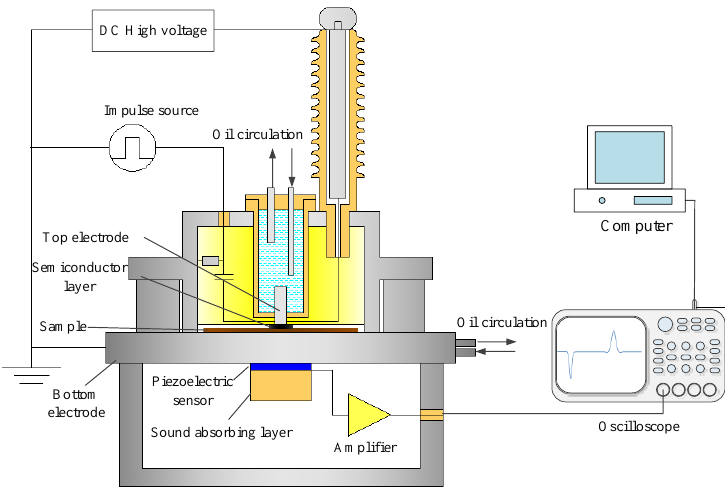
Figure 5. The space charge distribution measurement system.